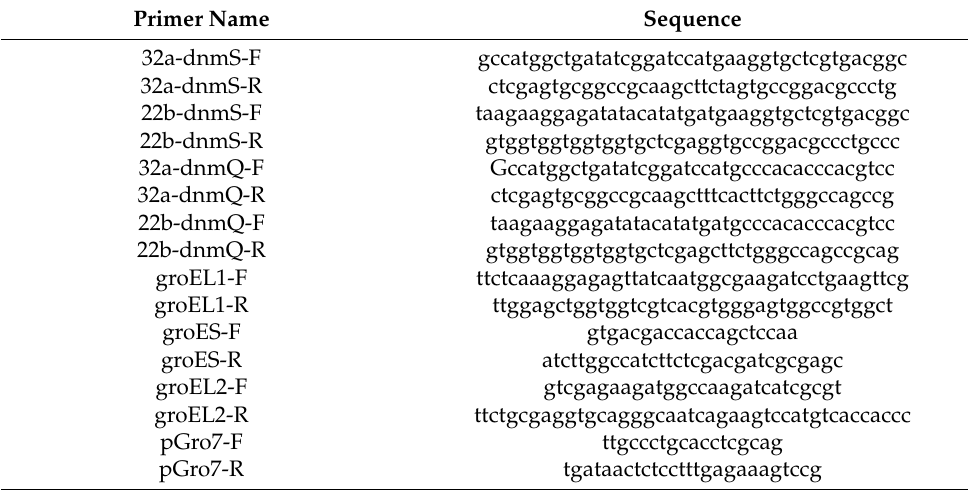
Table 2. The primers used in this